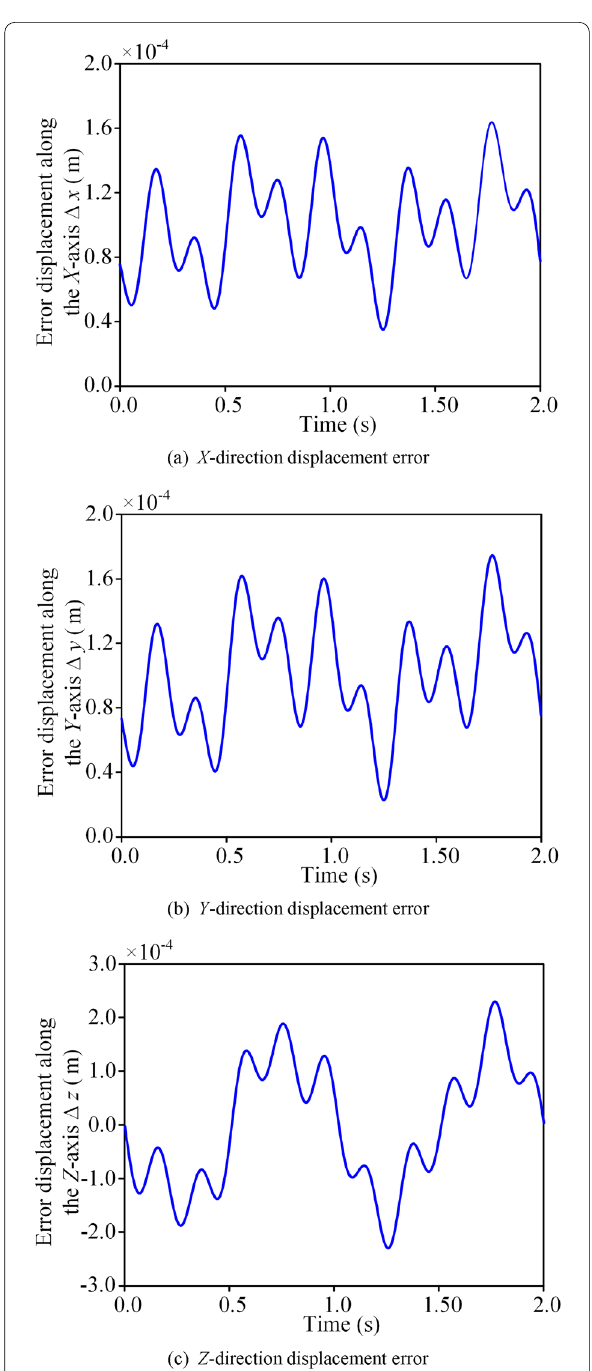
Figure 12 Position displacement error of moving